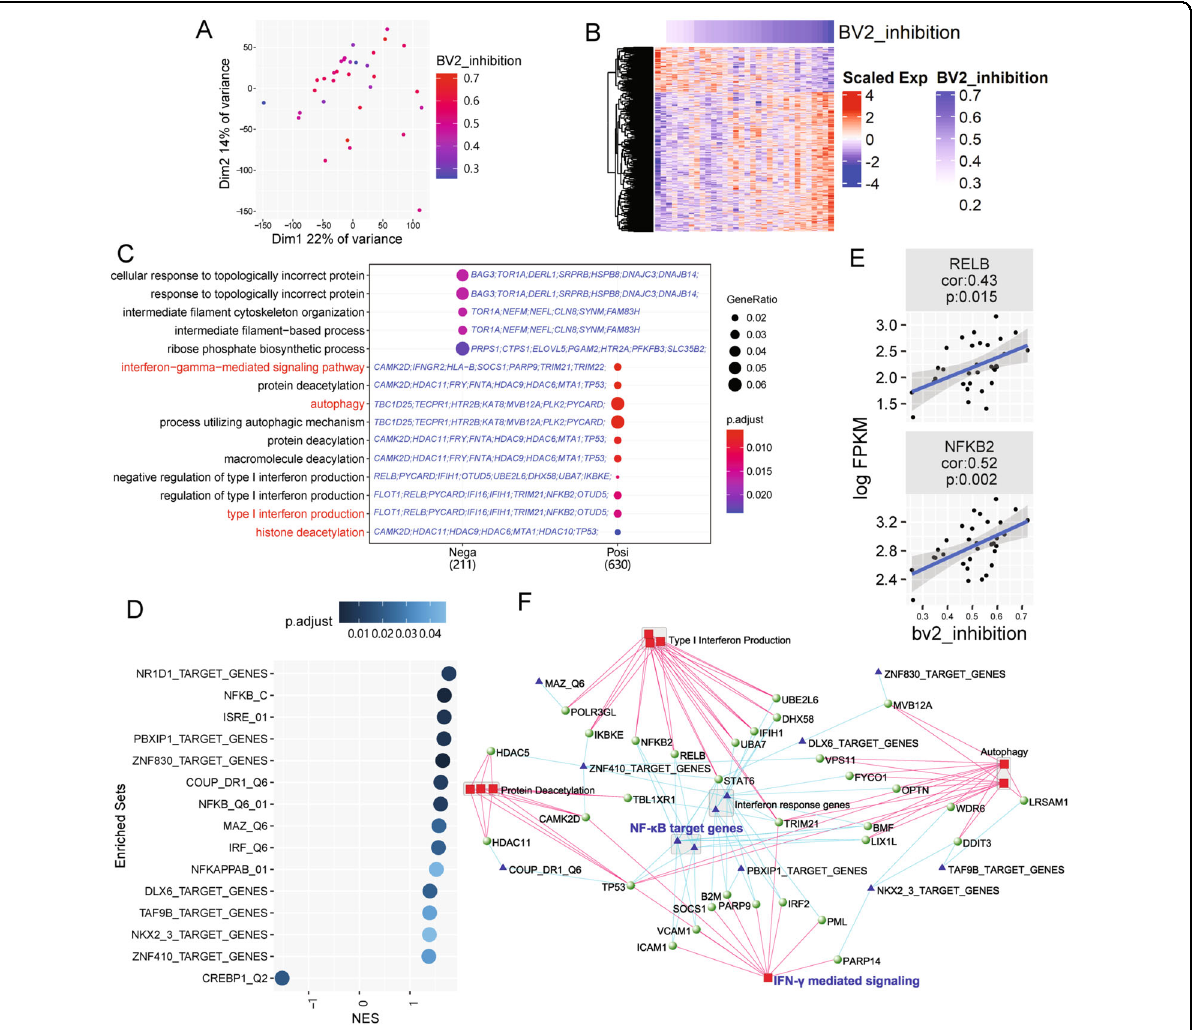
Fig. 3 Transcriptomic analysis of 32 lines of huMSCs revealed functional modules related to BV2-suppression capacity. A PCA of 32 huMSC lines. B Heatmap shows expression and clustering of genes, expression of which signi fi cantly correlated to BV2 inhibition capacity of 32 lines of huMSCs. C GO enrichment analysis of BV2 inhibition correlated genes. IFN- γ , autophagy, and related terms are highlighted in red, which are positively correlated with BV2 inhibition. Candidate genes belonging to each GO term are shown in blue. D GSEA analysis of enriched TFBS targeting gene sets, most of which, except for one, were positively correlated with BV2 inhibition (normalized enrichment score (NES) > 0). E Correlation between gene expression levels of two subunits of NF- κ B complex and BV2 inhibition capacity. F Network shows connection between enriched GO terms, TFBS targeting gene sets, and positively correlated genes. Red squares represent GO terms and blue triangles represent TFBS targeting gene sets. The nodes of green balls are genes, which belonging to both corresponding GO terms and TFBS targeting gene